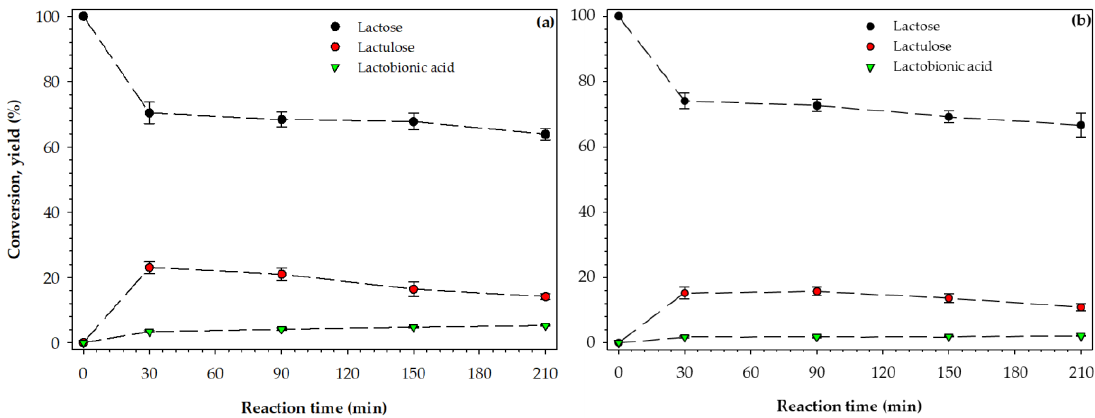
Figure 5. Conversion of lactose and yield of lactulose and lactobionic acid over time in: ( a ) sweet whey permeate (SWP), and ( b ) acid whey permeate (AWP). Temperature = 60 °C and pressure = 60 bar, and stirring rate 600 rpm.